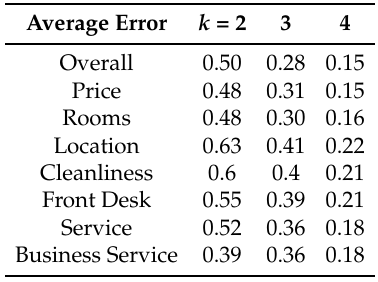
Table 14. Average error using rounding